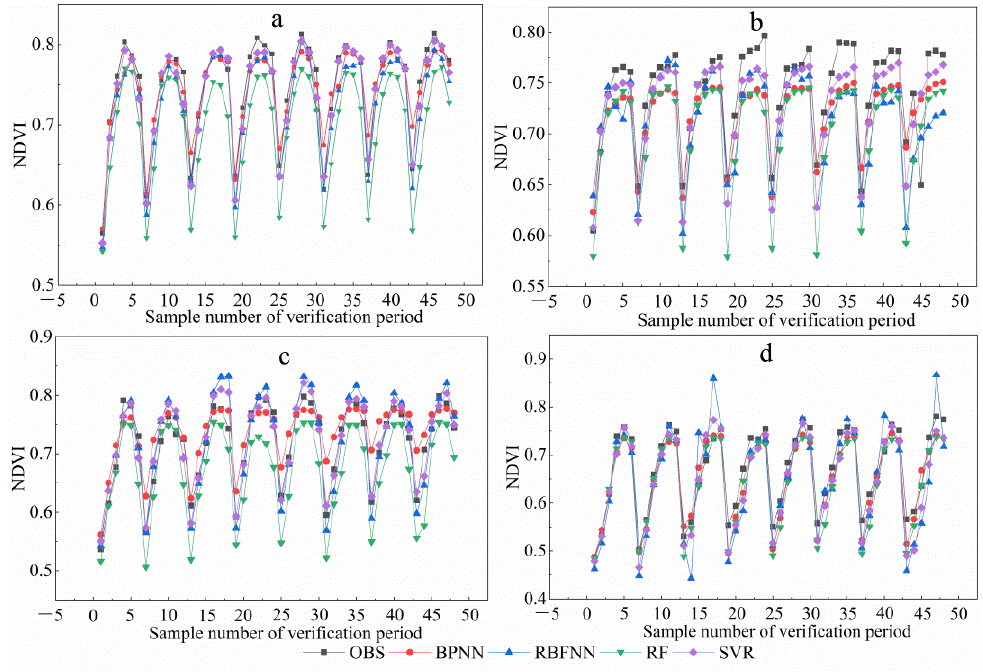
Figure 7. Comparison of the observed and BPNN, RBFNN, RF, and SVR predicted NDVI in the ( a ) karst trough valley, ( b ) karst peak-cluster depression, ( c ) karst plateau, and ( d ) karst basin.